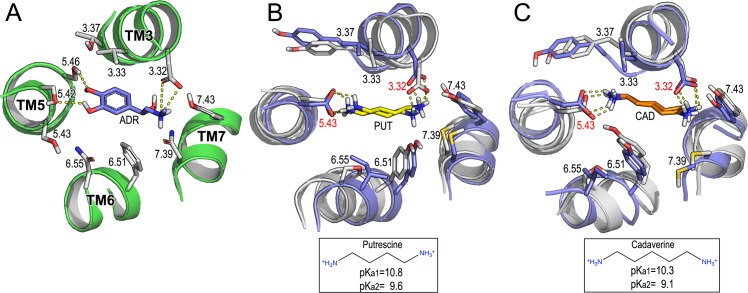
Molecular interactions of PUT and CAD with human TAAR6 and TAAR8.(A) Key features of the full agonist adrenaline (ADR, blue sticks) in the binding pocket of the ADRB2 active structure (PDB ID:4LDO; region comprising the TMs 3-5-6-7 in green ribbons). (B) Superposition of molecular docking of putrescine (PUT, yellow sticks), and (C) cadaverine (CAD, orange sticks), in the active-like TAAR6 (light-gray ribbons) and TAAR8 (light-blue ribbons) molecular models. Contact residues at a distance < 3.5 Å from ligands are shown in sticks and numbered according to Ballesteros-Weinstein numbering. Predicted (ligand–receptor) hydrogen bonds and salt bridge interactions are shown in dashed lines. The 2D chemical structure of PUT and CAD protonated at physiological pH, with estimated pKa1 and pKa2 for each amino group are indicated at the bottom of panels B and C, respectively.